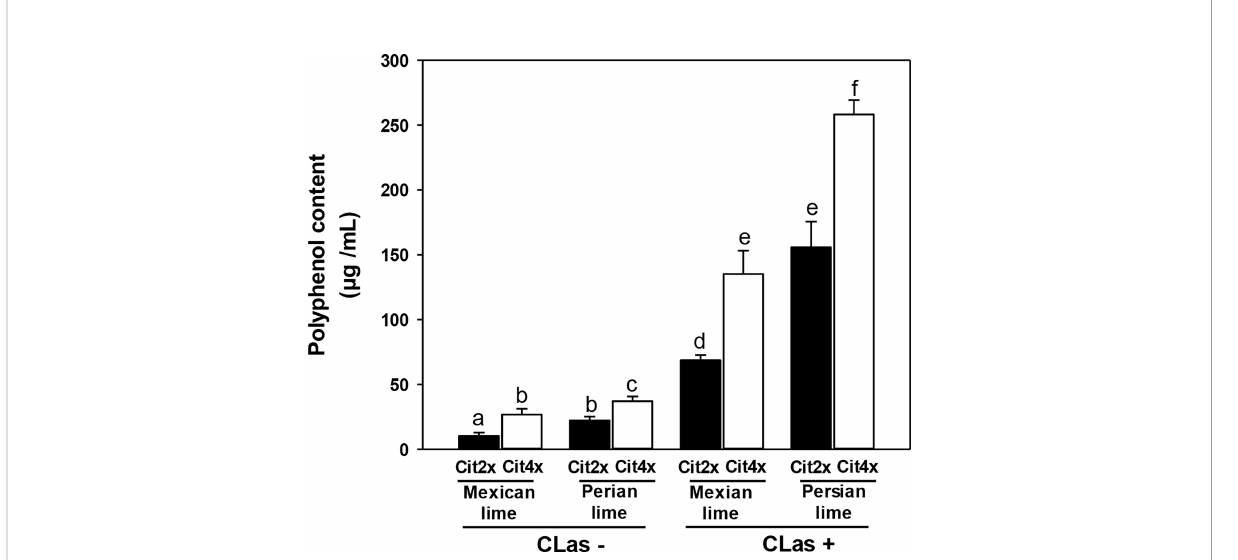
FIGURE 6 Polyphenols content in 2x and 4x roots of Swingle citrumelo rootstocks grafted with Mexican lime and Persian lime infected (CLas+) or not (CLas-). Cit2x and Cit4x mean 2x swingle citrumelo and 4x swingle citrumelo, respectively. Data with a different letter are statistically different. Vertical bars indicate the mean value ±